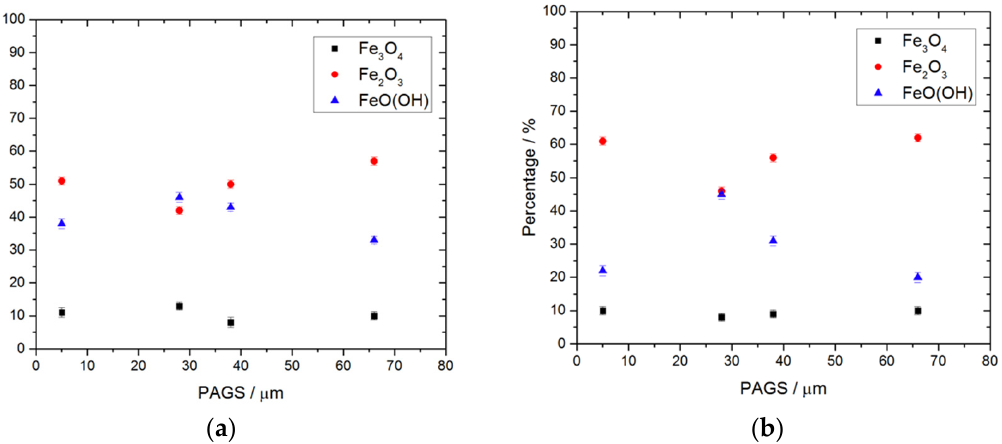
Figure 6. The fractions of oxides and hydroxide depending on PAGS for samples passivated with potentiostatic polarization at ( a ) 0.2 V and ( b ) 0.4 V.